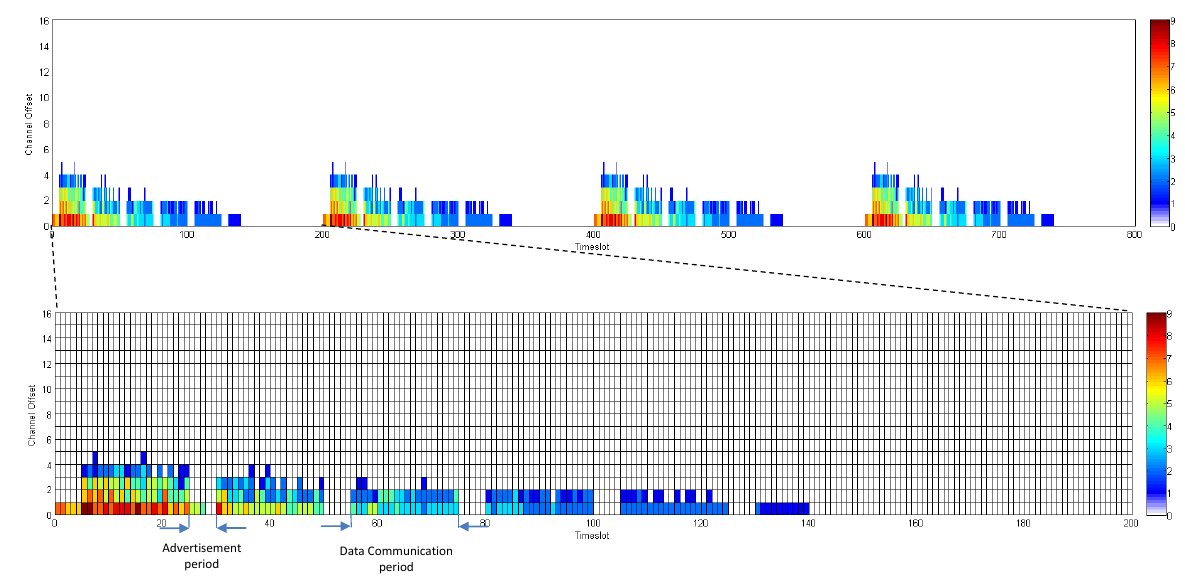
Figure 22. The combination of schedule-matrix of the current slot/channel usage for the sample D-MSR network.